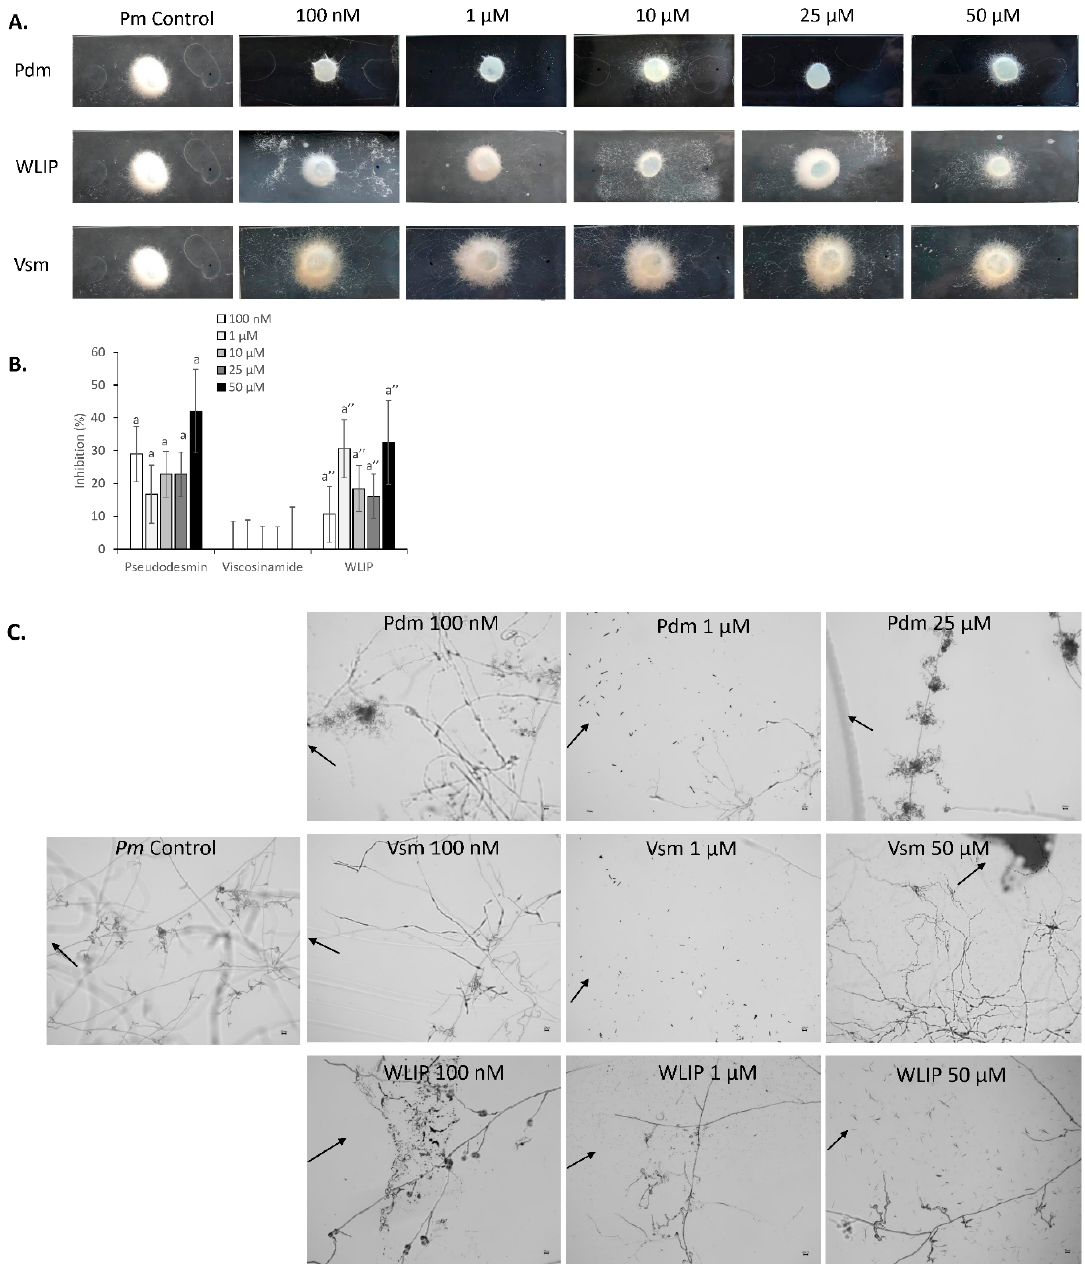
Figure 7. Effect of pseudodesmin, viscosinamide and WLIP on the mycelial growth and hyphal morphology of P. myriotylum CMR1. ( A ) Effect of various CLP treatments and concentrations on the growth of P. myriotylum CMR1 (Pm). For each CLP, concentrations of 100 nM, 1 µM, 10 µM, 25 µM and 50 µM were tested. Representative images are shown. ( B ) Percentage inhibition of P. myriotylum CMR1 in response to various CLP treatments and concentrations. Values indicate percentage growth inhibition relative to the control ( n = 5). The data were analyzed using Tukey’s post-hoc tests via SPSS statistics 25. Bars with different letters indicate significant differences ( p < 0.05) between treatments; vertical lines indicate the standard error (SE). The letters a and a’ were used to denote statistics within treatments for pseudodesmin and WLIP respectively. ( C ) Microscopic assays showing the effect of various CLP treatments and concentrations on the mycelia of P. myriotylum CMR1. Arrows indicate the position of the CLP droplets.